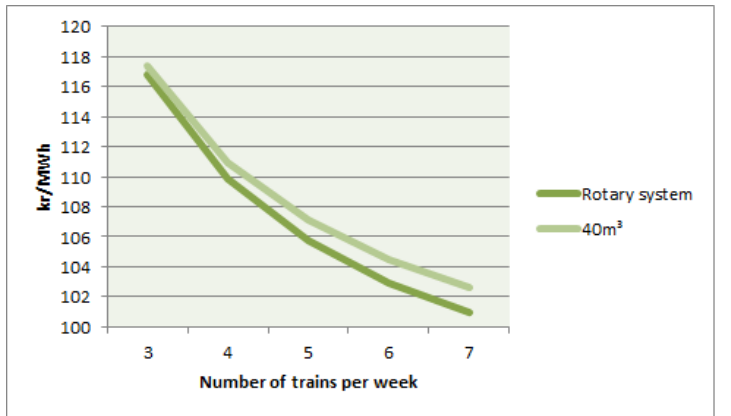
Figure 12. Comparison between a 300 km transport with rotary system or 40m 3